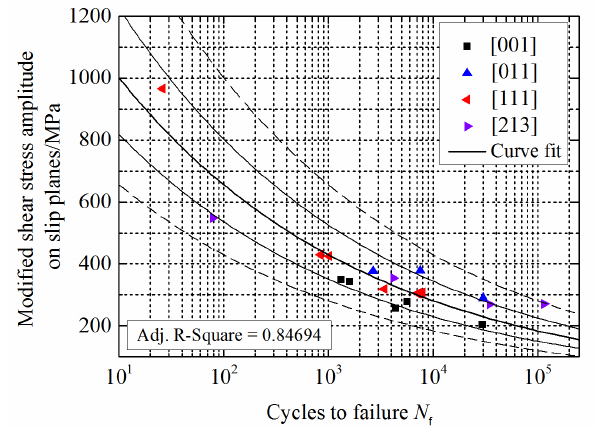
Figure 7. Fatigue life prediction for PWA1480 material at 648 °C using the proposed model.